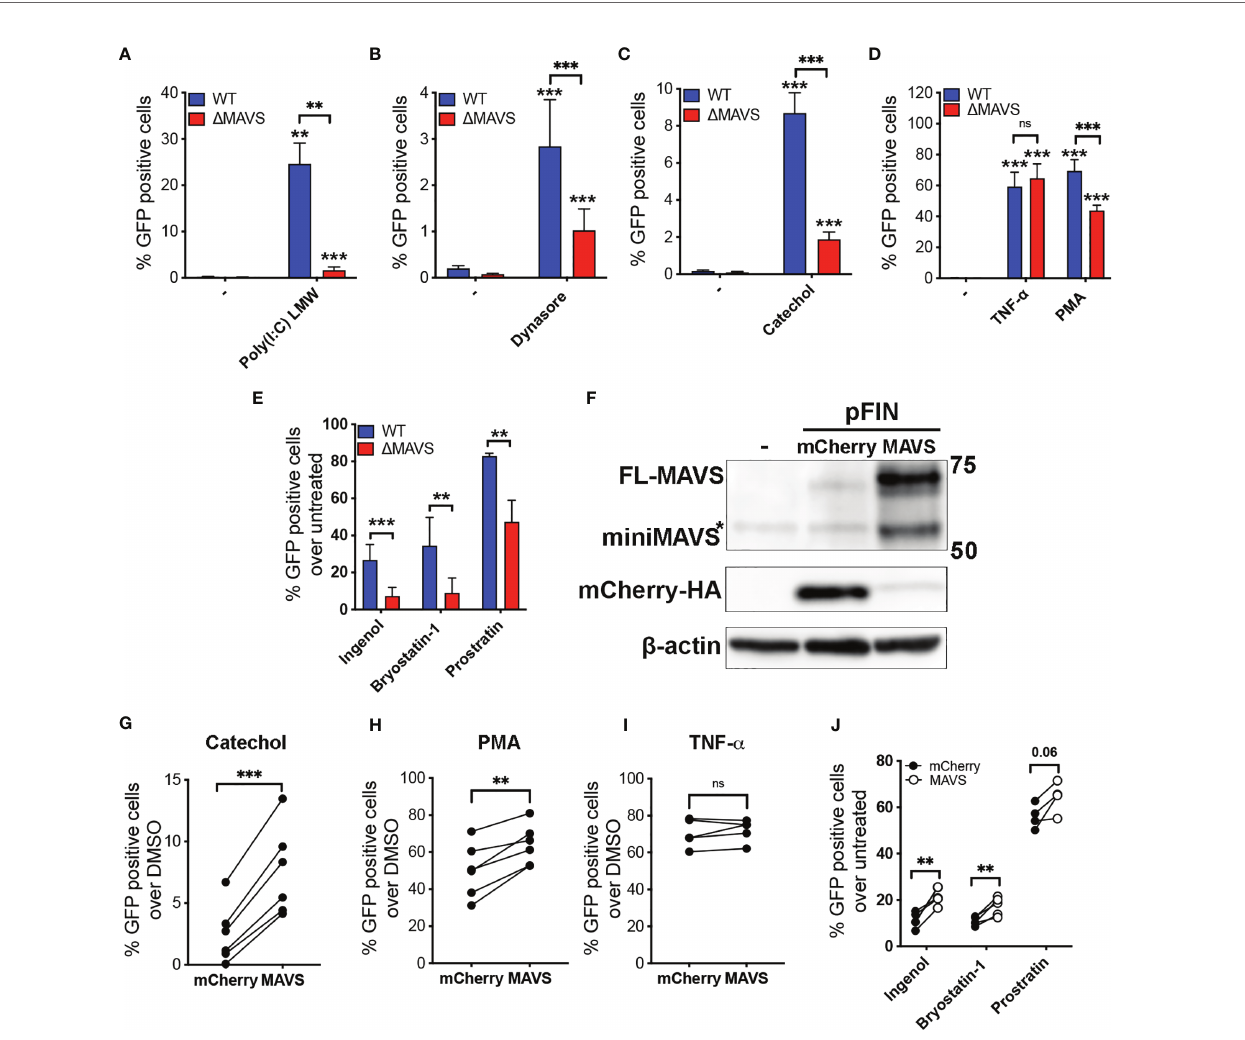
FIGURE 4 | MAVS is necessary for ef fi cient viral reactivation mediated by RIG-I agonists, Dynasore, Catechol and PKC agonists. J-Lat-WT and J-Lat - D MAVS S7 and F2 clones were tested in their ability to reactivate latent HIV-1 with transfected RIG-I agonist Poly(I:C) LMW (A) , Dynasore (B) , Catechol (C) , TNF- a or PMA (D) or Ingenol, Bryostatin-1 and Prostratin (E) . % GFP positive cells were measured by fl ow cytometry. Data are represented as mean ± SD of fi ve biological replicates performed in triplicates. Mann-Whitney test was used to calculate p-values between WT and D MAVS J-Lat clone. (F) J-Lat - D MAVS was complemented using a lentiviral vector containing MAVS or an empty vector. Levels of MAVS were analyzed by western. MAVS-transduced or control mCherry-transduced J-Lat - D MAVS cells were treated for 24 hours with either Catechol (G) , PMA (H) , TNF- a (I) , or Ingenol, Bryostatin-1 and Prostratin (J) . % GFP positive cells were measured by fl ow cytometry. Data are represented as mean of fi ve or six biological replicates perform in triplicates. Two-sample paired t-test analysis was used to calculate p-values between MAVS-transduced or control mCherry-transduced J-Lat - D MAVS cells. (**p < 0.01; ***p < 0.001; ns, not signi fi